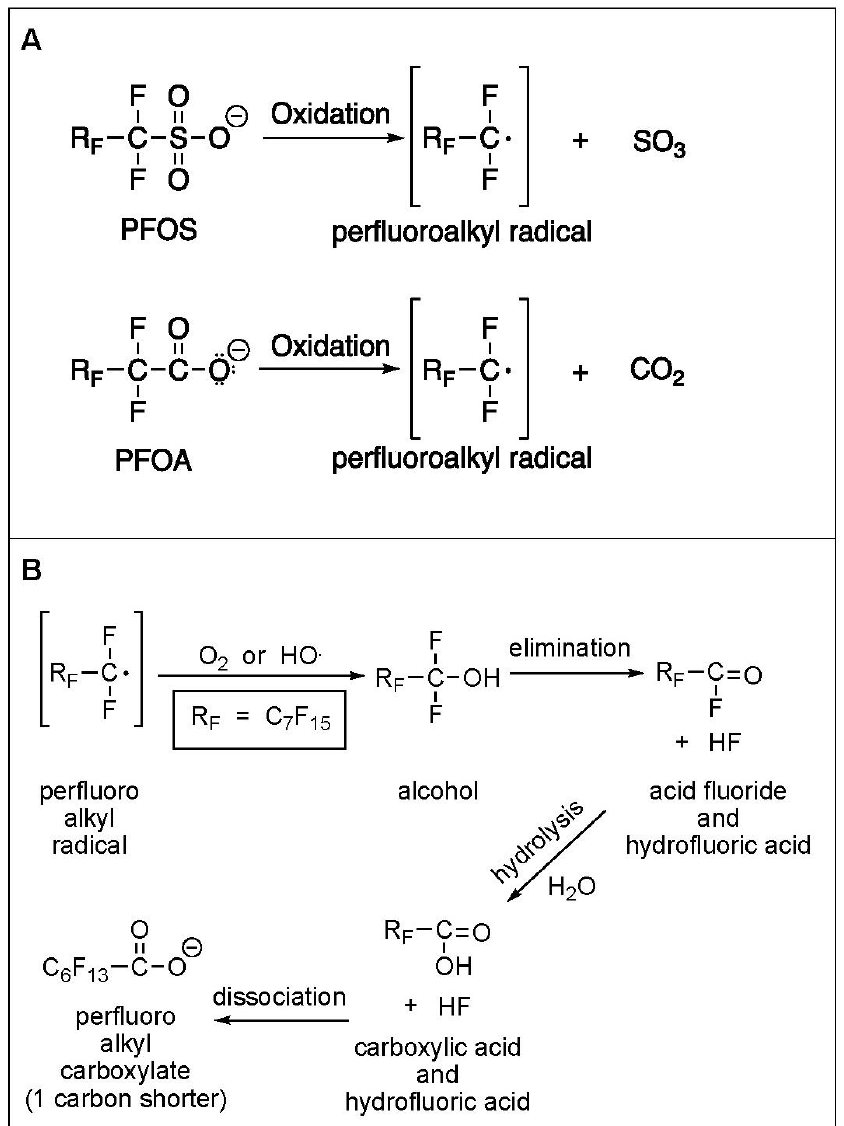
Figure 1. ( A ) Rate-limiting step for the treatment of PFOS versus PFOA to the perfluoroalkyl radical; ( B ) subsequent degradation of perfluoroalkyl radical.